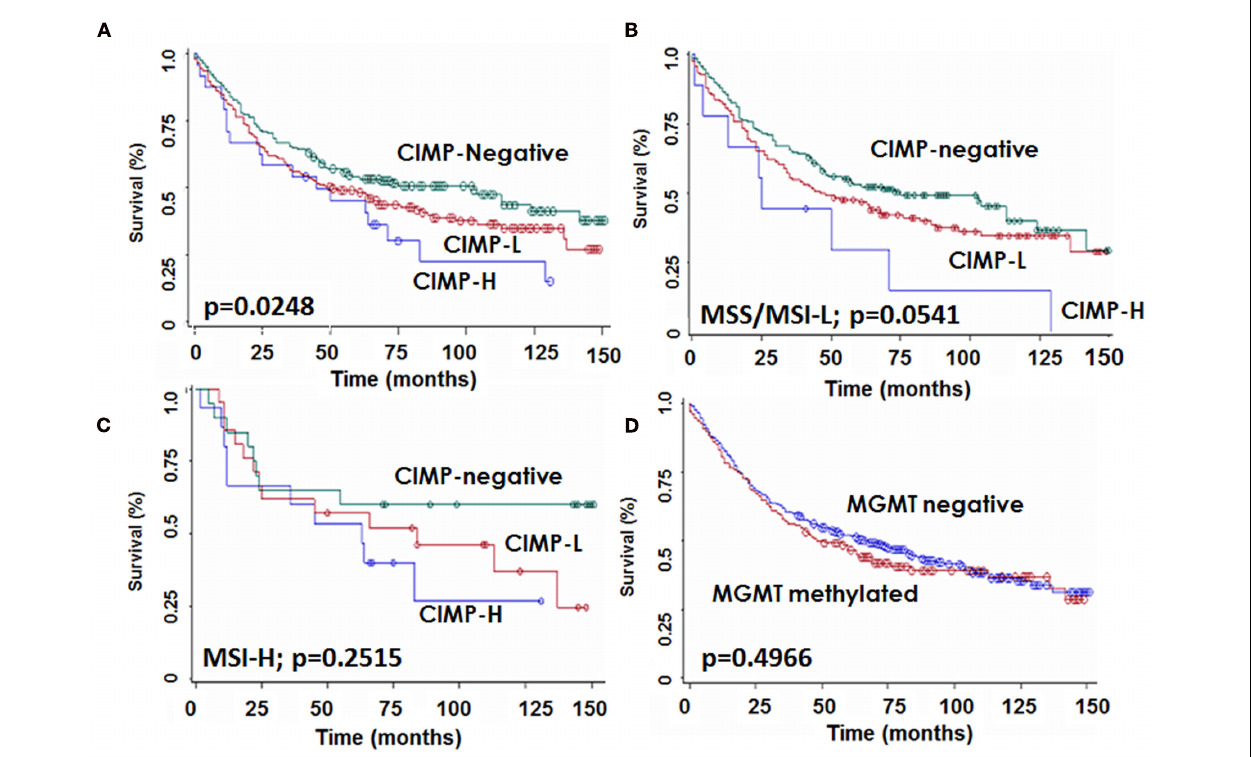
FIGURE 3 | Kaplan–Meier survival curves showing survival time differences for patients with CIMP-H, CIMP-L, and -negative tumors (A) in the whole patient cohort, (B) in microsatellite stable or instable-low (MSS/MSI-L) and (C) in microsatellite instable-high (MSI-H) cases, and (D) for patients stratified by MGMT status.